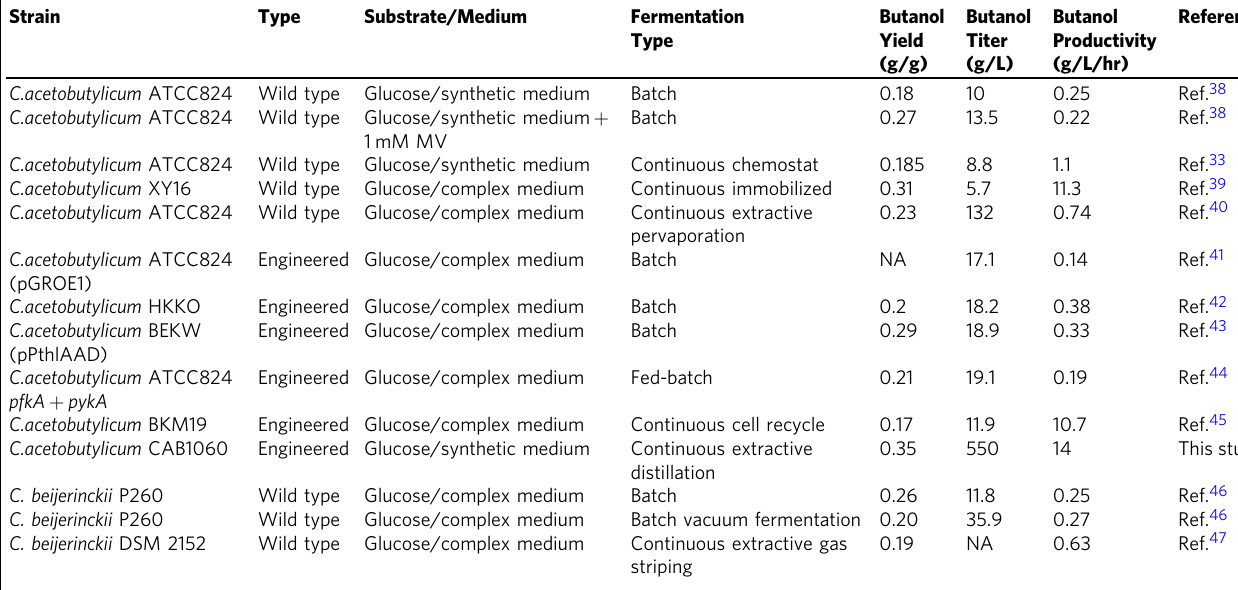
Table 1 Representative studies of high level butanol production in C. acetobutylicum and C. beijerinckii